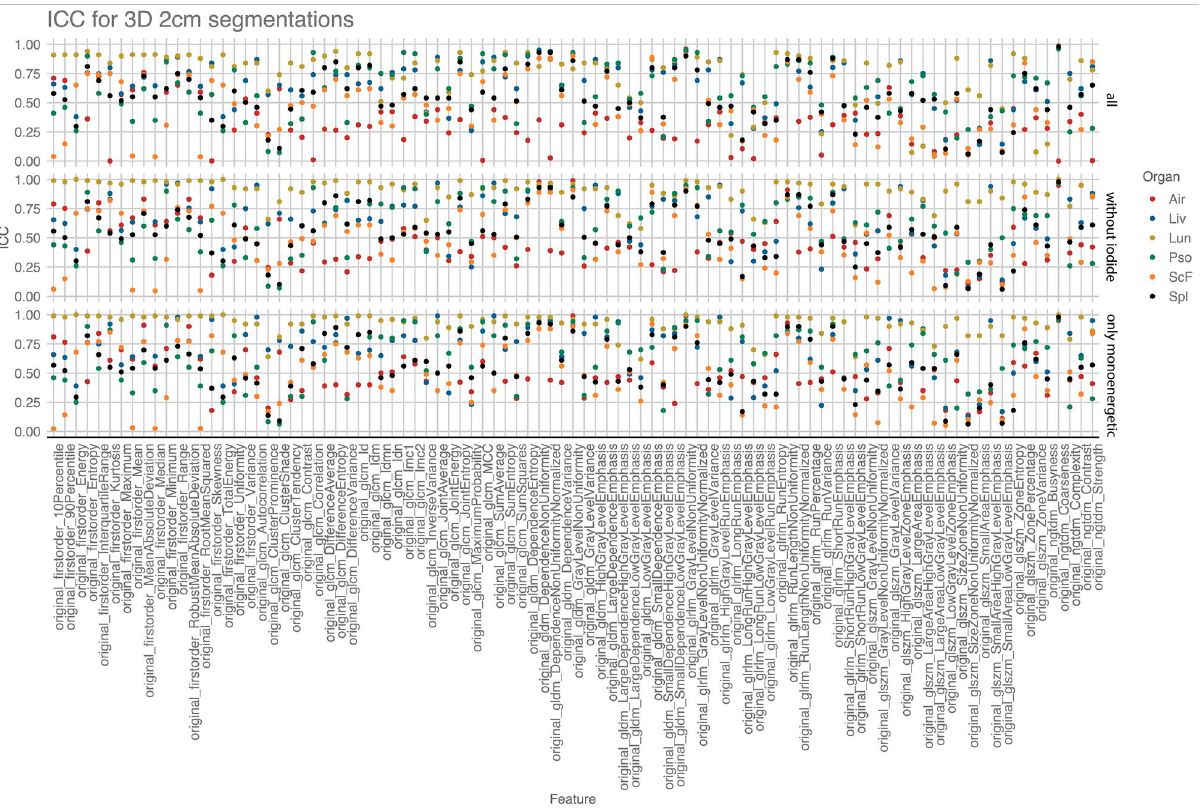
Figure 3. ICC values compared for (1) all reconstructions, (2) excluding iodine maps and (3) only monoenergetic reconstructions.